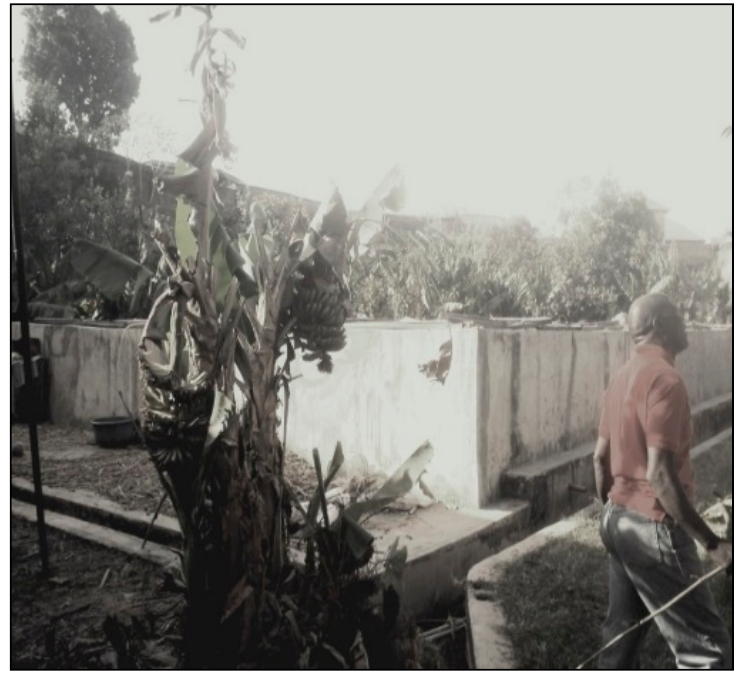
Figure 3. Concrete pond.